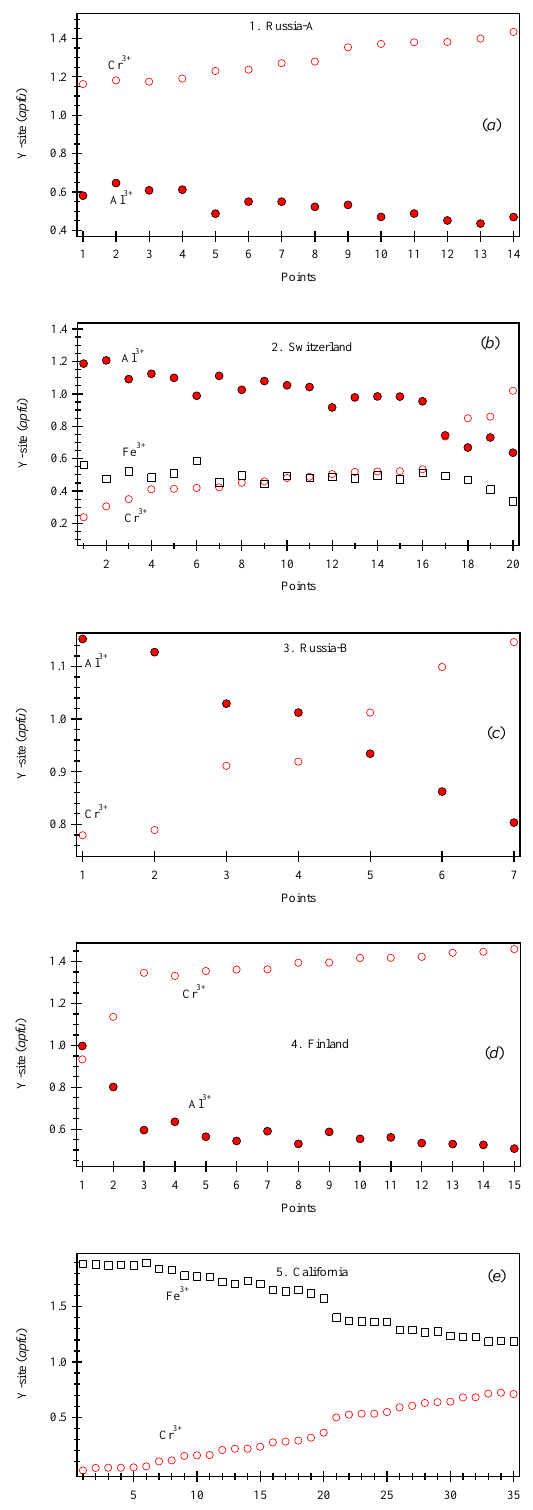
Figure 6. Variations for the dominant Y-site cations for the five Uv samples: ( a ) 1. Russia-A, ( b ) 2. Switzerland, ( c ) 3. Russia-B, ( d ) 4. Finland, and ( e ) 5. California. For each EPMA data point, apfu were obtained from each sample (some are given in Table 2), and the cations on the Y site are shown graphically. The point analyses are ordered in terms of the dominant Y-site cation.